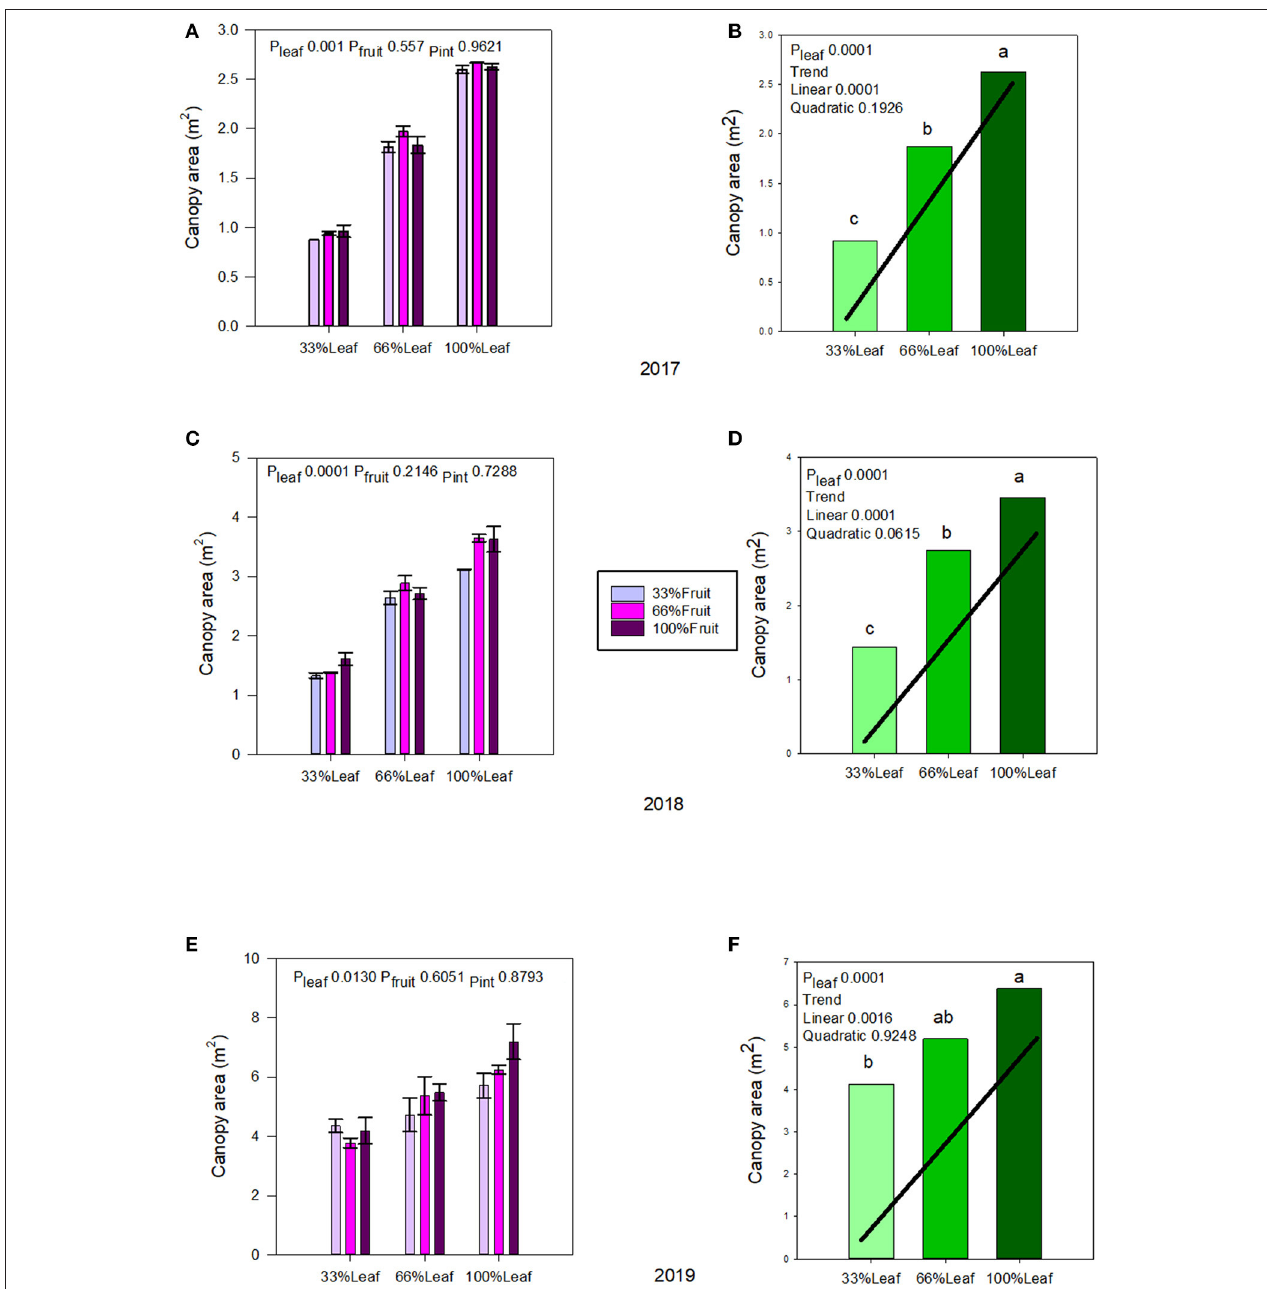
FIGURE 2 | Effect of defoliation and fruit removal on the canopy area of Cabernet Sauvignon grapevine in 2017 (A,B) , 2018 (C,D) , and 2019 (E,F) . The interactive effects and simple means with standard error of the mean in each year are presented in (A,C,E) . The main effect of defoliation with significant trend line are presented in (B,D,F) . Columns with different letters in the main effect panel are significantly different at P < 0.05 according to Tukey’s HSD.